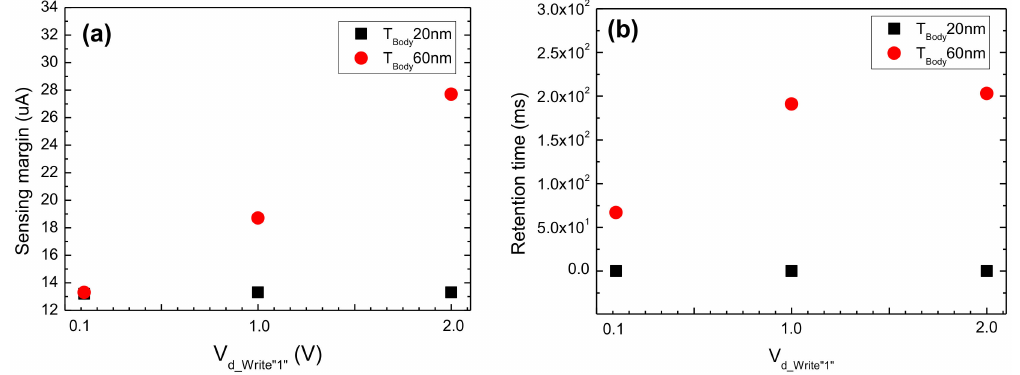
Figure 9. The ( a ) sensing margin and ( b ) retention time of T Body 20 nm and T Body 60 nm for three Write“1” operating drain